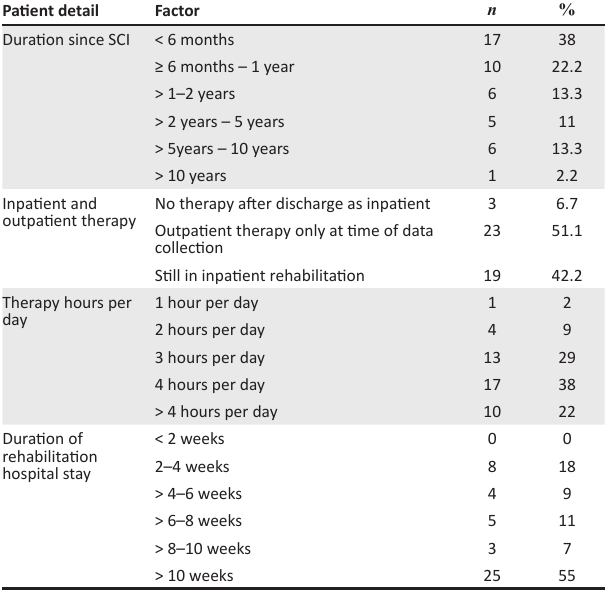
TABLE 2: Duration since spinal cord injury and extent of treatment after spinal cord injury. Patient detail Factor